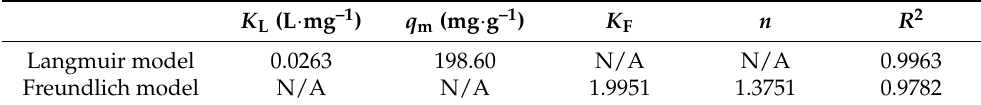
Figure 7. Fitting curve of ( A ) the Langmuir and ( B ) Freundlich isothermal adsorption models. Table 3. Langmuir and Freundlich isothermal adsorption models for Cd(II) fitting parameters.